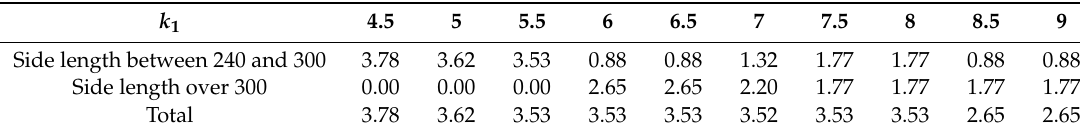
Table 1. Average number of constructed LSFRs with a di ff erent k 1 .